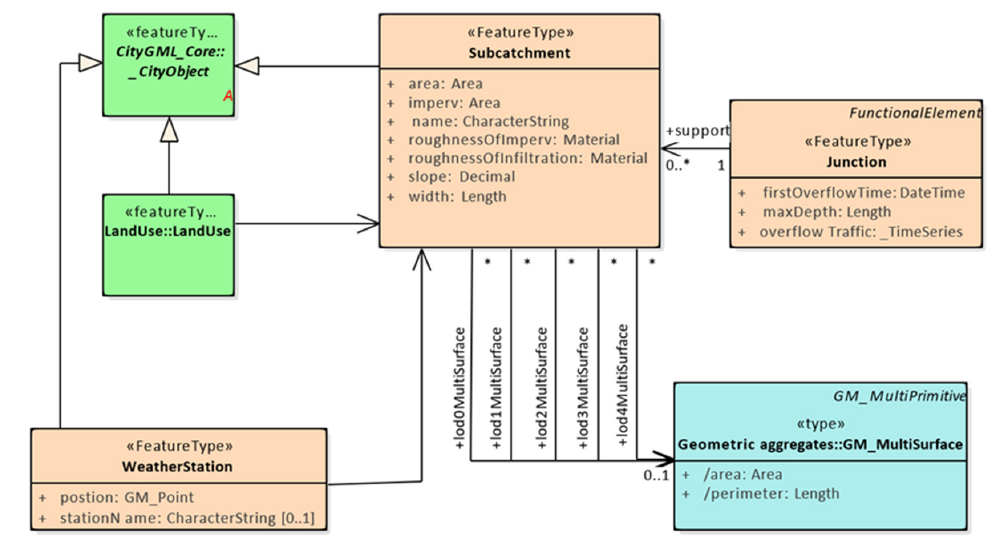
Figure 5. UML class diagram of Subcatchment.